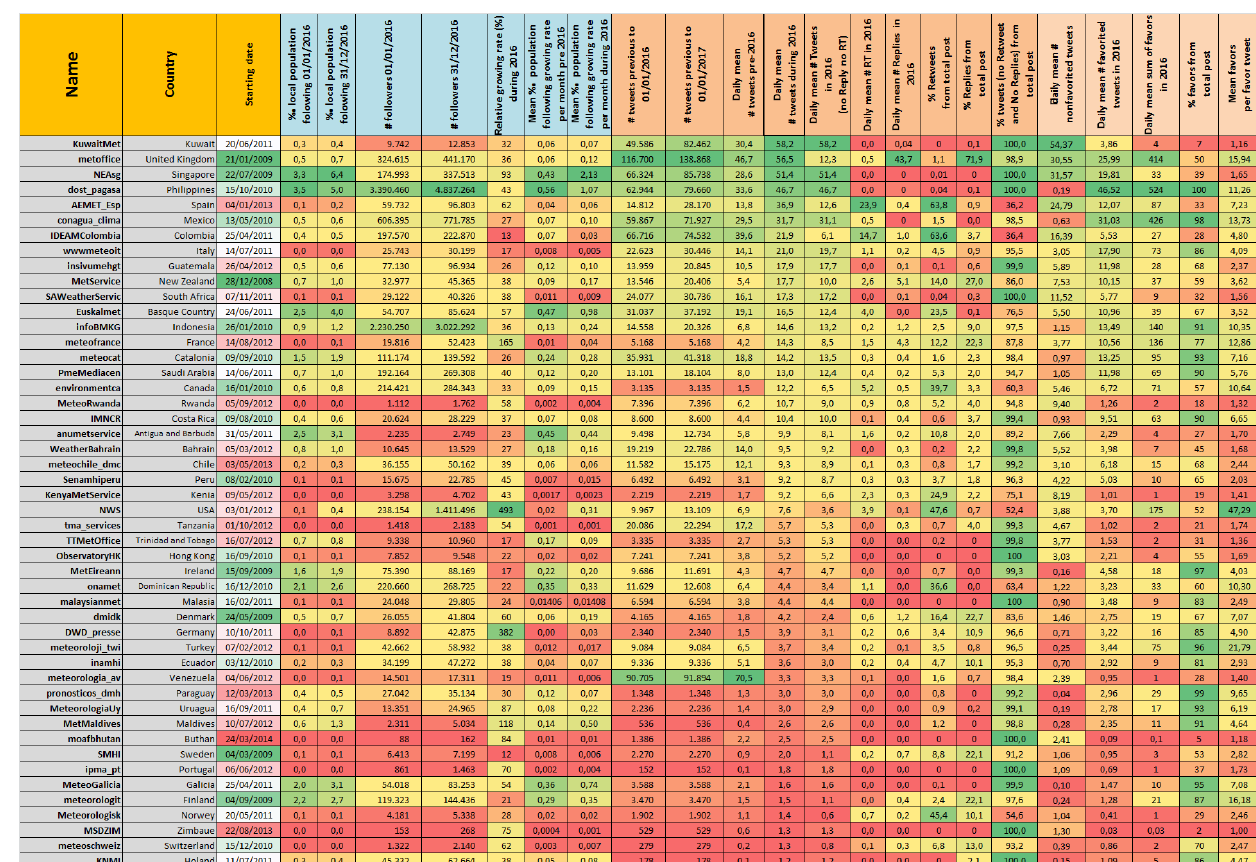
Figure 1. Summary of some metrics and statistics for followers and tweets considering different aspects about the weather services included in this study. Ordered by mean daily number (#) of messages posted (tweets) during 2016. Cell colors from high values in green to low values in